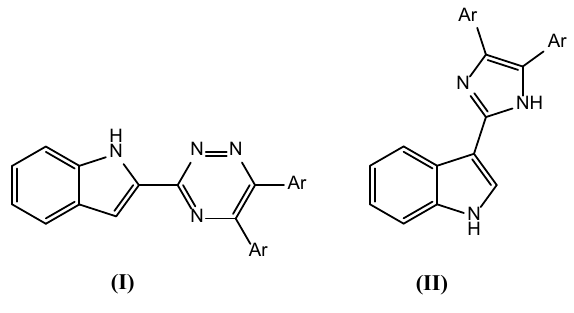
Figure 1: Structure of indole hybridized with triazine (I) and imidazole